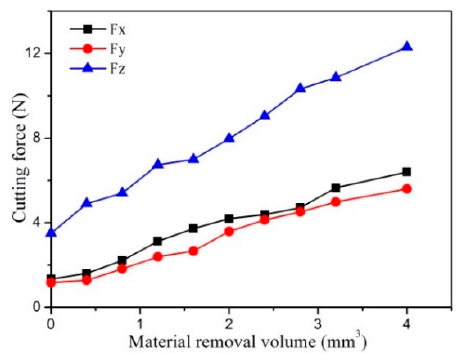
Figure 13. The effect of material removal volume on cutting force.